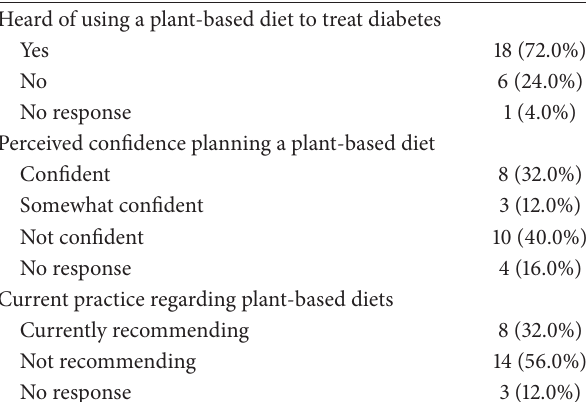
Table 3: Staff perception and recommendation for patient use of plant-based